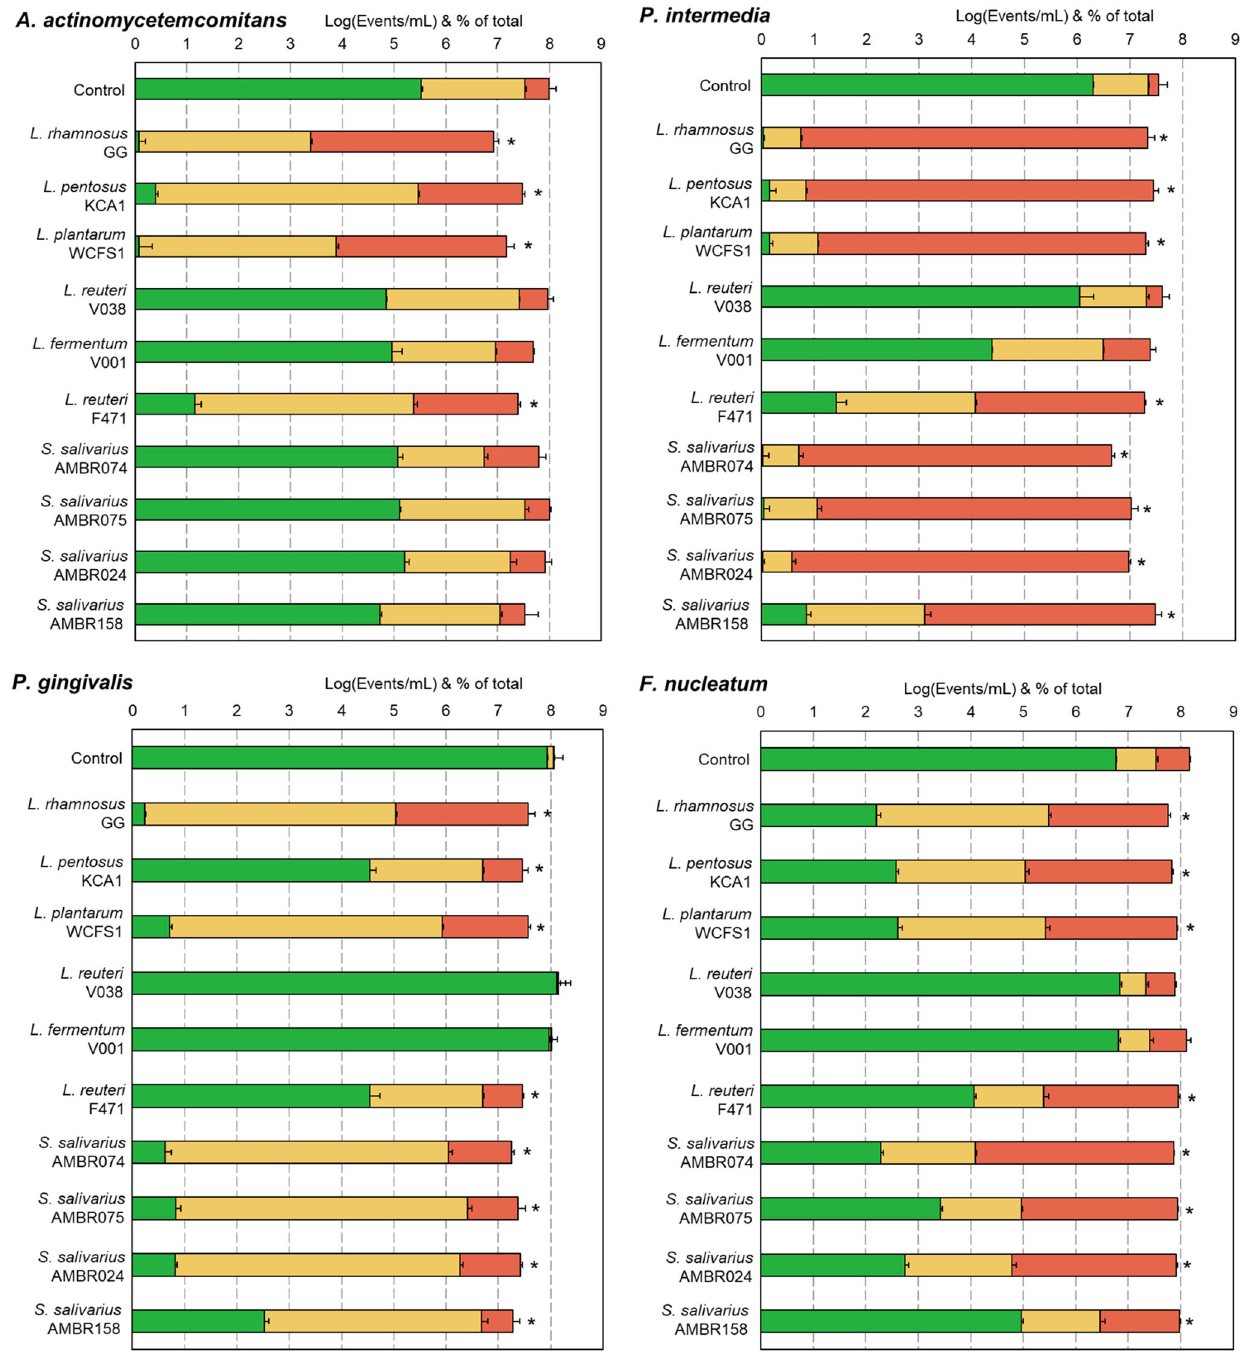
Fig. 1 Antimicrobial properties of probiotic ’ s cell-free supernatant. Flow cytometric quanti fi cation of antimicrobial properties of the cell- free supernatant (CFS) of the probiotic candidates (postbiotic) on the membrane permeability, as a proxy for viability, of periodontal pathobionts after 6 h of incubation in the postbiotic. Data presented as mean and standard deviation of log 10 of total events per mL (Log(Events/mL)) and percentage composition of the total divided into classes according to their permeability/viability: green = intact/live, red = permeable/dead and yellow = intermediate permeability/partially damaged membrane. Gates were de fi ned according to the degree of red fl uorescence through the entry of propidium iodide into healthy- and killed cultures (Supplementary Figs. 2 & 3). Statistical differences in remaining live cells compared to the control ( n = 3, ANOVA with Tukey HSD) are depicted with an